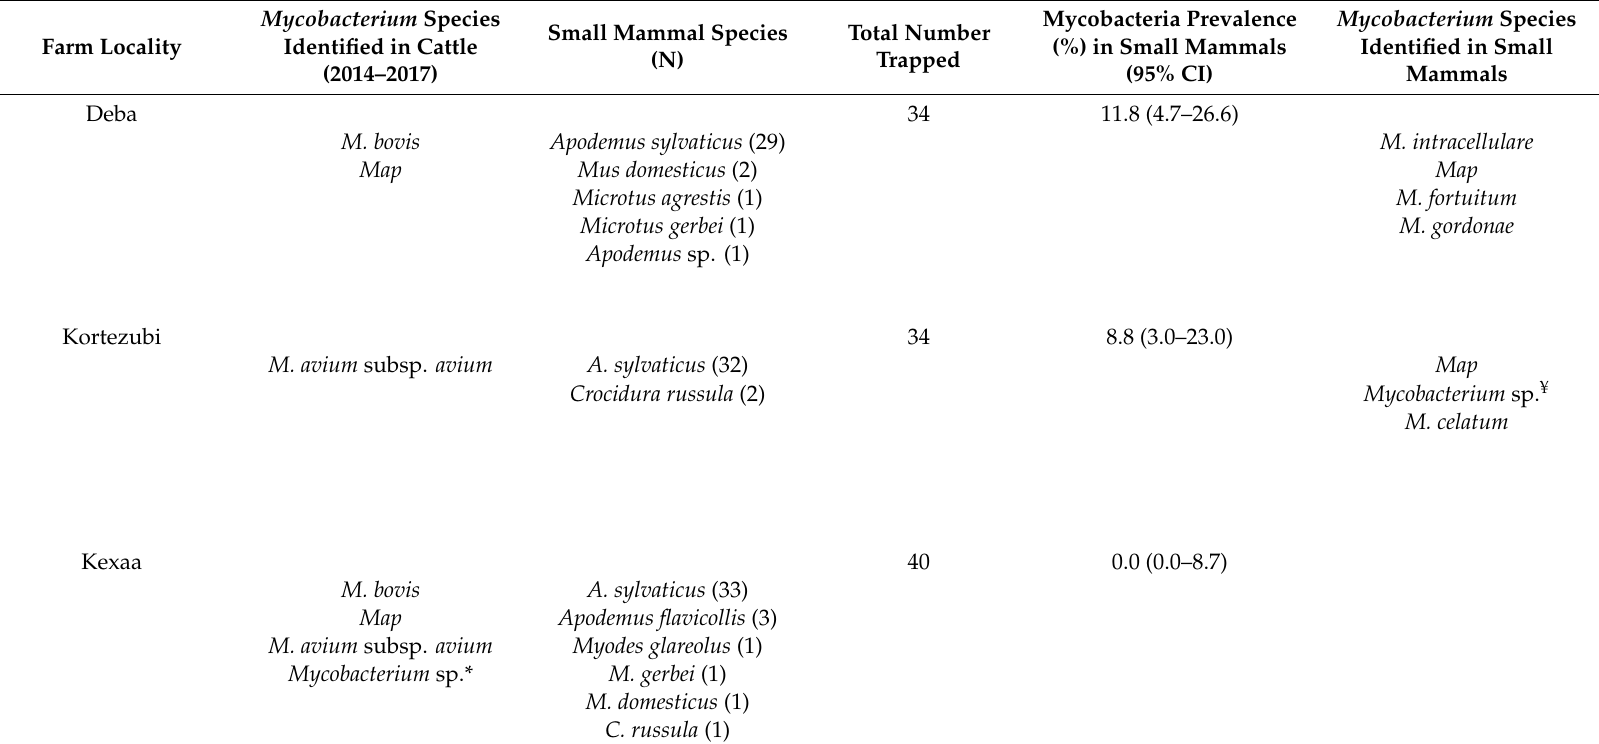
Table 1. Mycobacteria detected in cattle and small mammals at farm